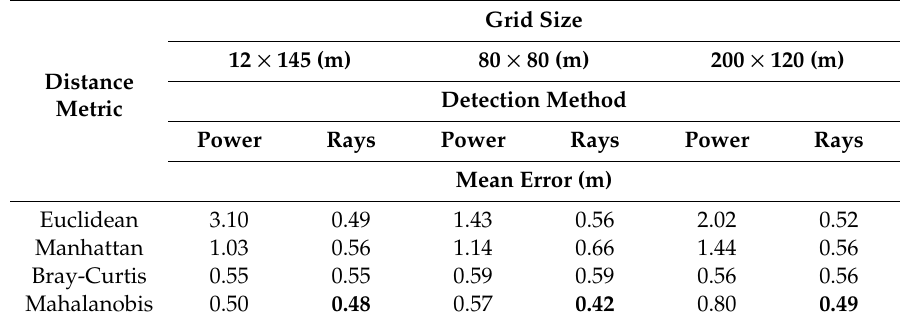
Table 4. Outdoor simulations results: Localization error when comparing power vs delay detection methods and distance metrics in each